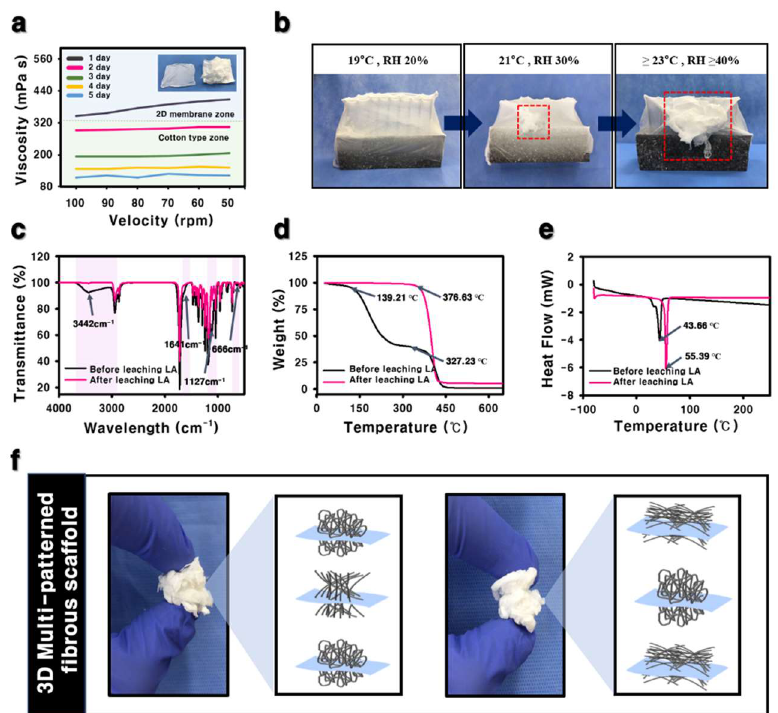
Figure 3. ( a ) Viscosity of PCL / LA solution by increasing mixing time. ( b ) Photographs of fibers dependent on RH and temperature. ( c ) FT-IR, ( d ) TGA, and ( e ) DSC analysis of the fibers ( f ) Photographs of the 3D cotton-type fibrous scaffolds with customized patterns.